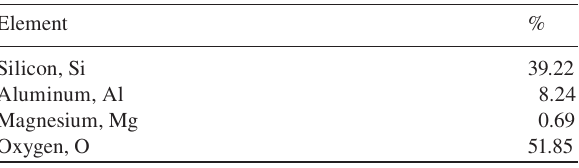
Table 2 Chemical elements of montmorillonite used.